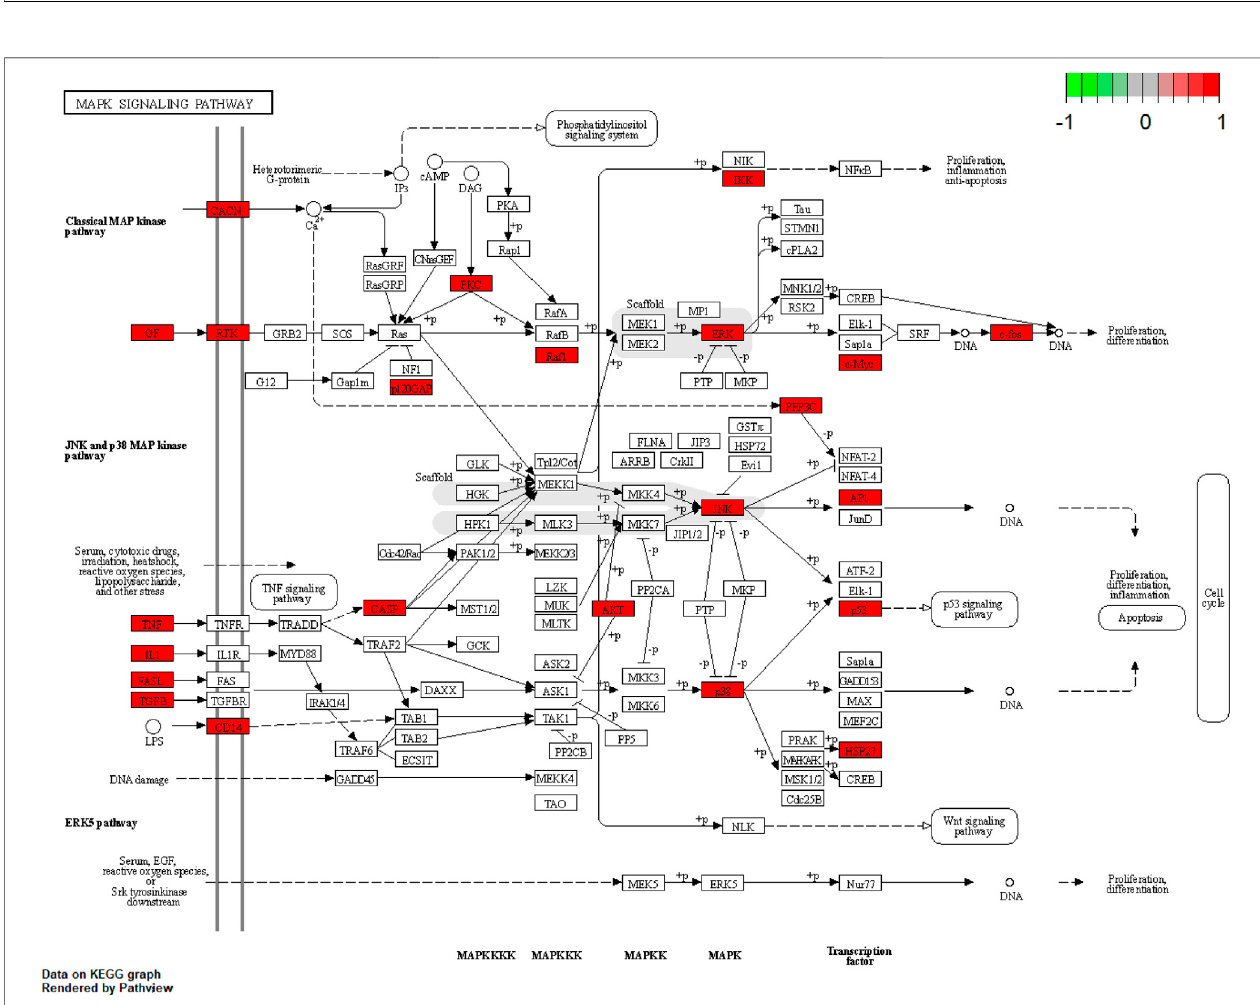
FIGURE 9 | MAPK signaling pathway map.